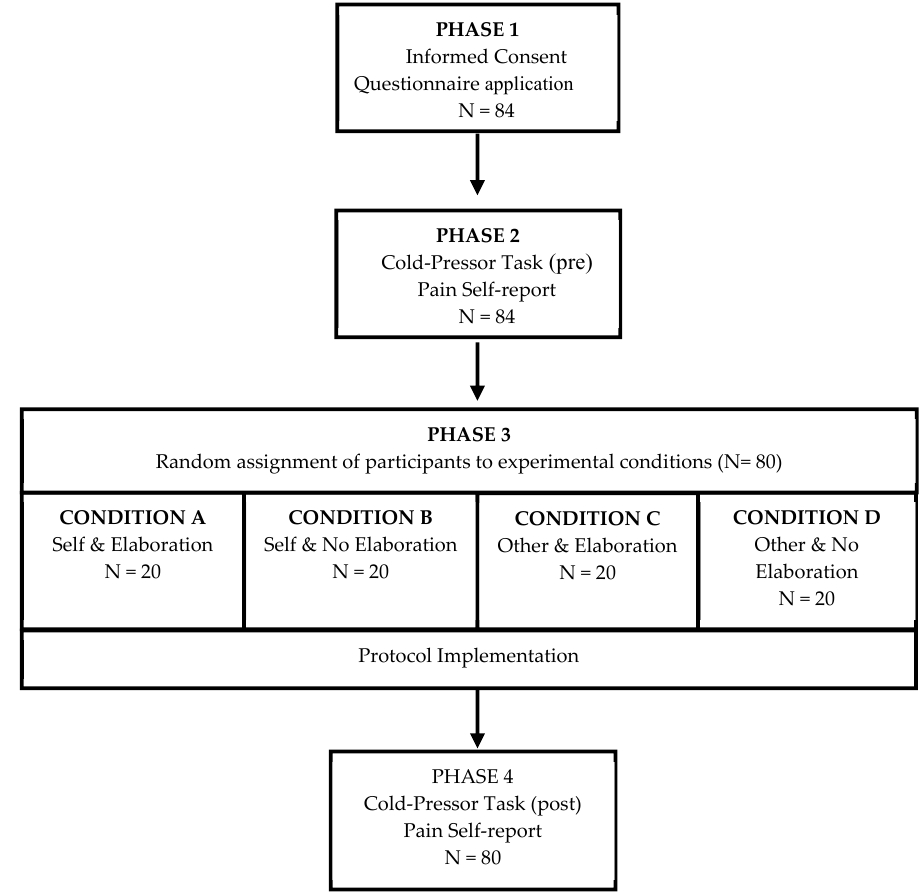
Figure 1. Overview of the experimental procedure.